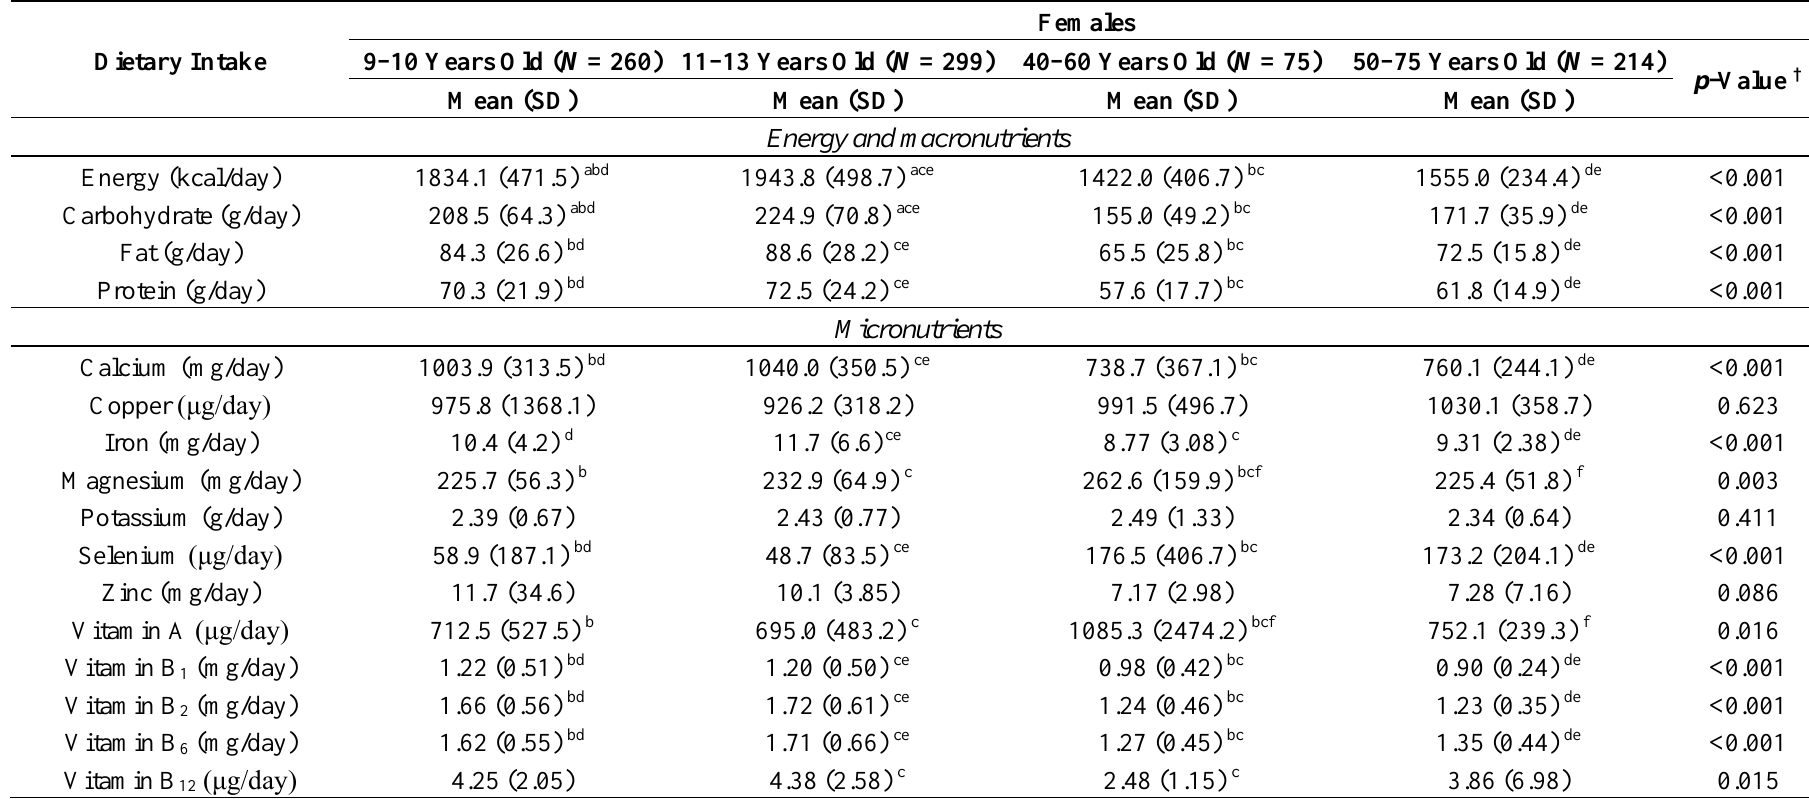
Table 3. Average energy, macronutrient and micronutrient intakes in girls, middle-aged women and postmenopausal women in Greece presented by age